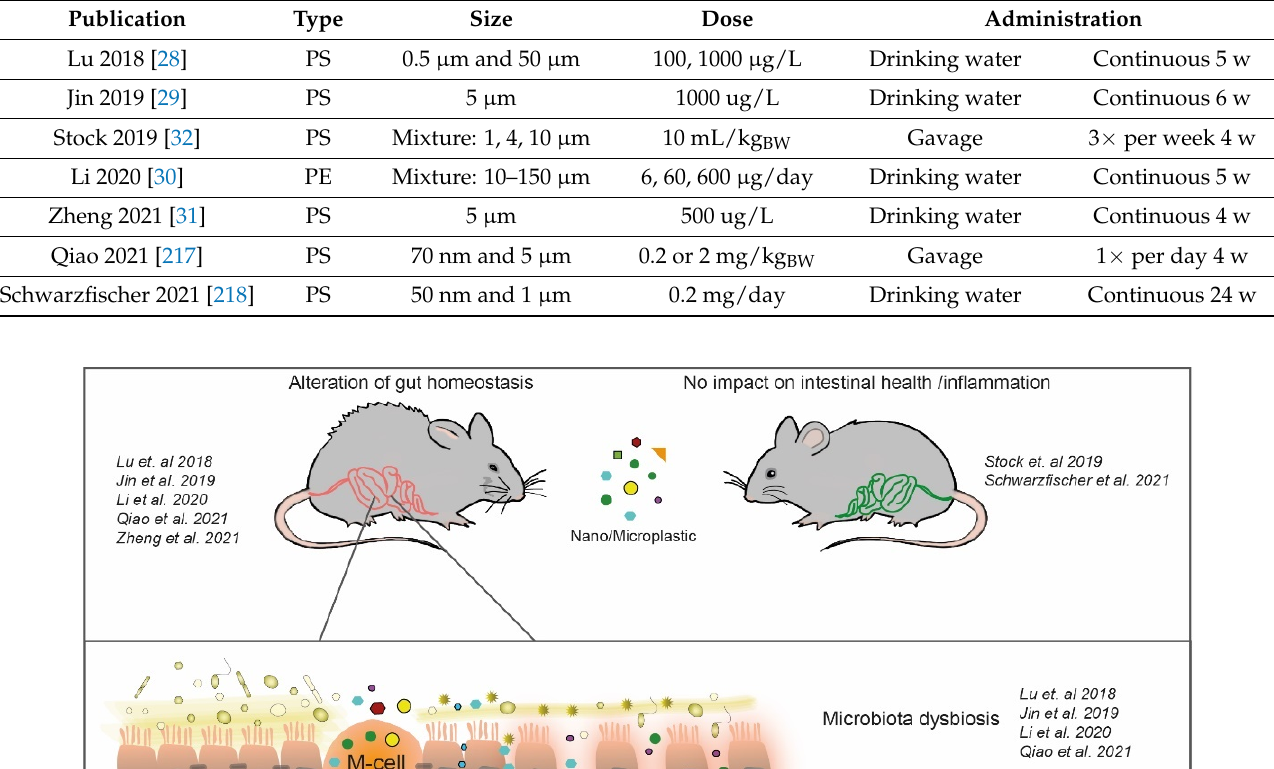
Table 1. Literature Search: Impact of NP and MP on intestinal health of rodents.